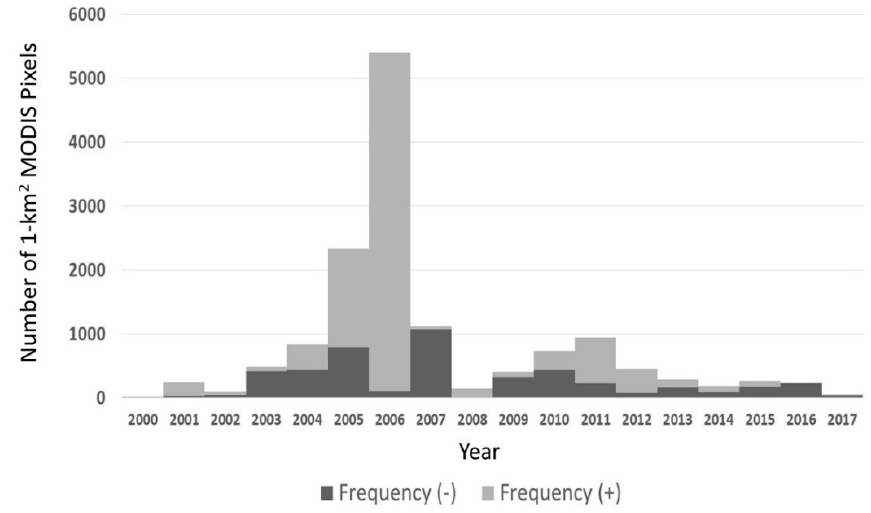
Figure 7. Yearly distribution of positive (warming) and negative (cooling) breakpoints detected from structural change analysis of LST of the DRECP study area between 2000 and 2018 for the MODIS 1-km monthly time series.